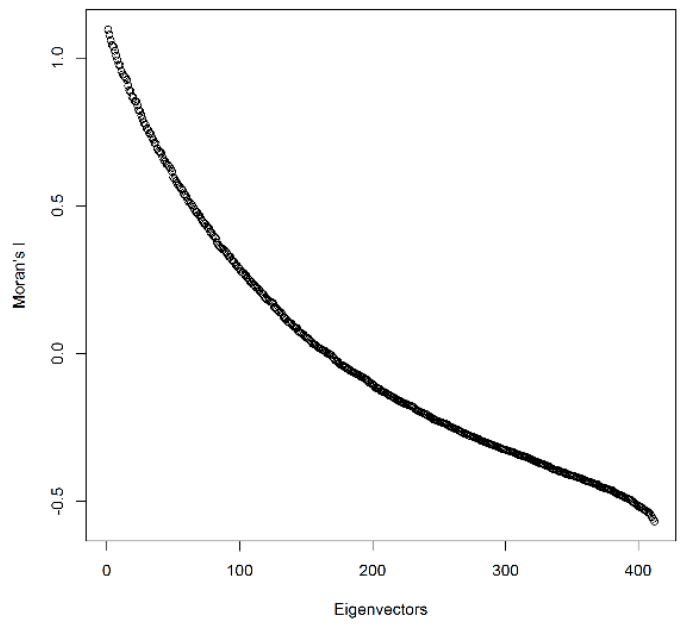
Figure 4. Moran’s I values of the eigenvectors. Table 3. Eigenvectors selected with a stepwise regression selection procedure.